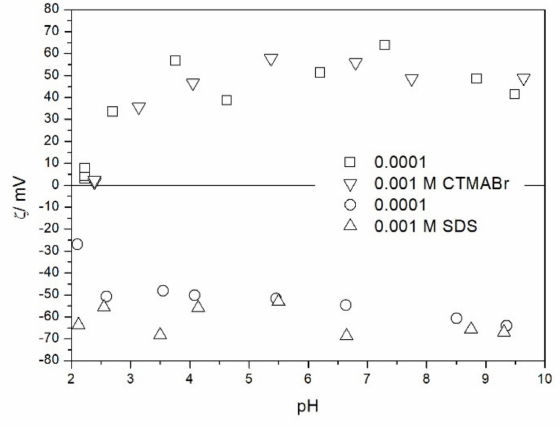
Figure 8. The zeta potential of TeO 2 in the presence of ionic surfactants and 0.001 M NaCl.